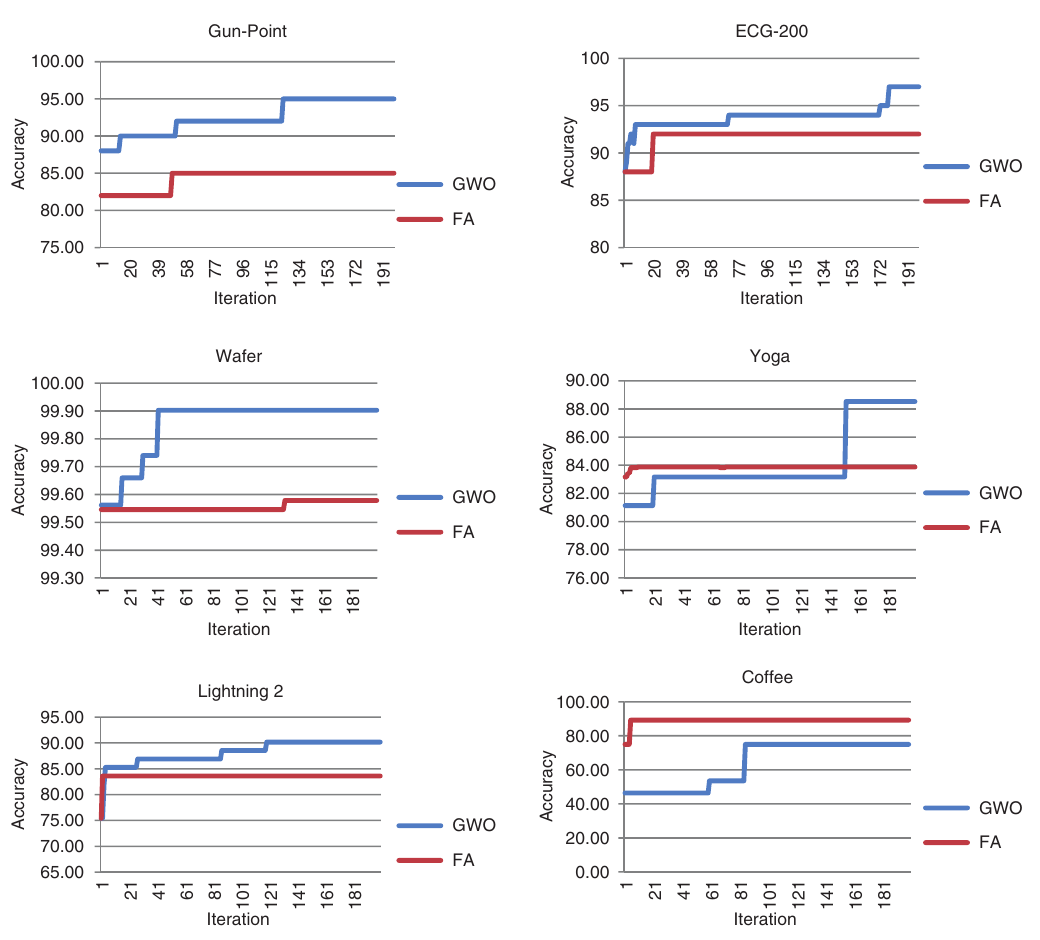
Figure 4: Convergence Characteristics of GWO and